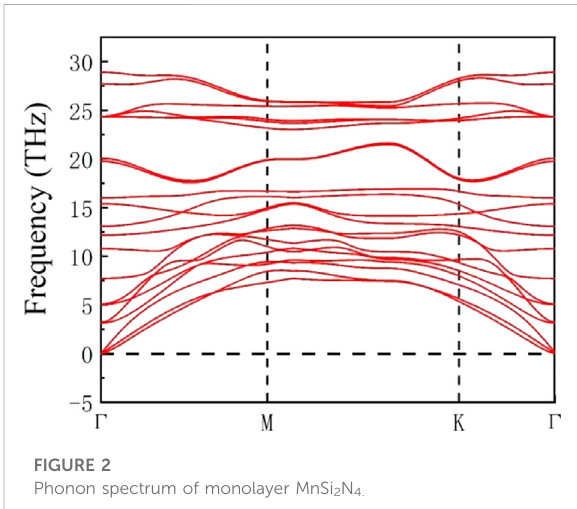
FIGURE 2 Phonon spectrum of monolayer MnSi 2 N 4.